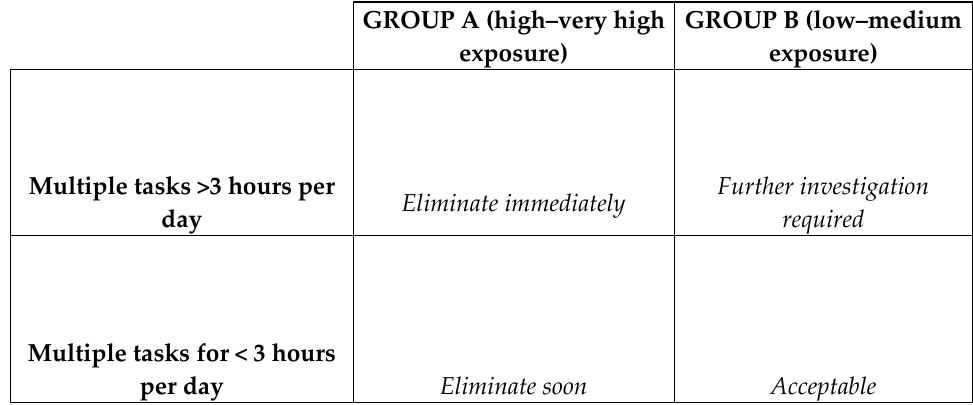
Figure 2. Action priority matrix.